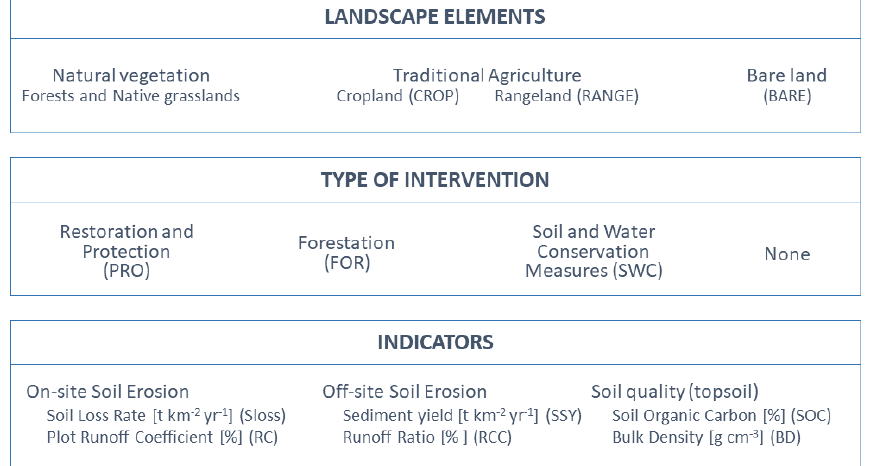
text tables and supplementary material was copied and tabu- lated in